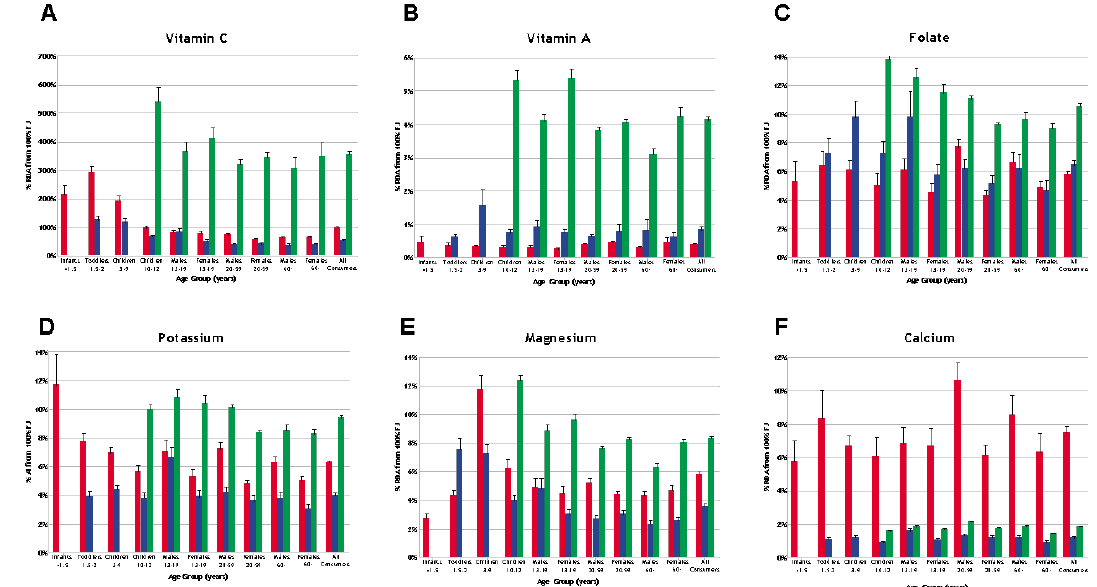
Figure 2. Percentage recommended dietary allowance (RDA) of vitamin C ( A ), vitamin A ( B ), folate ( C ), potassium ( D ), magnesium ( E ), and calcium ( F ) contributed by 100% FJ in individuals reporting the consumption of 100% FJ in the U.S. (red bars), UK (blue bars), and Brazil (green bars) (mean + SEM). Note, the “all consumers” category does not include infants < 1.5 years for the UK and children < 10 years for Brazil, as these individuals were not included in the respective surveys.